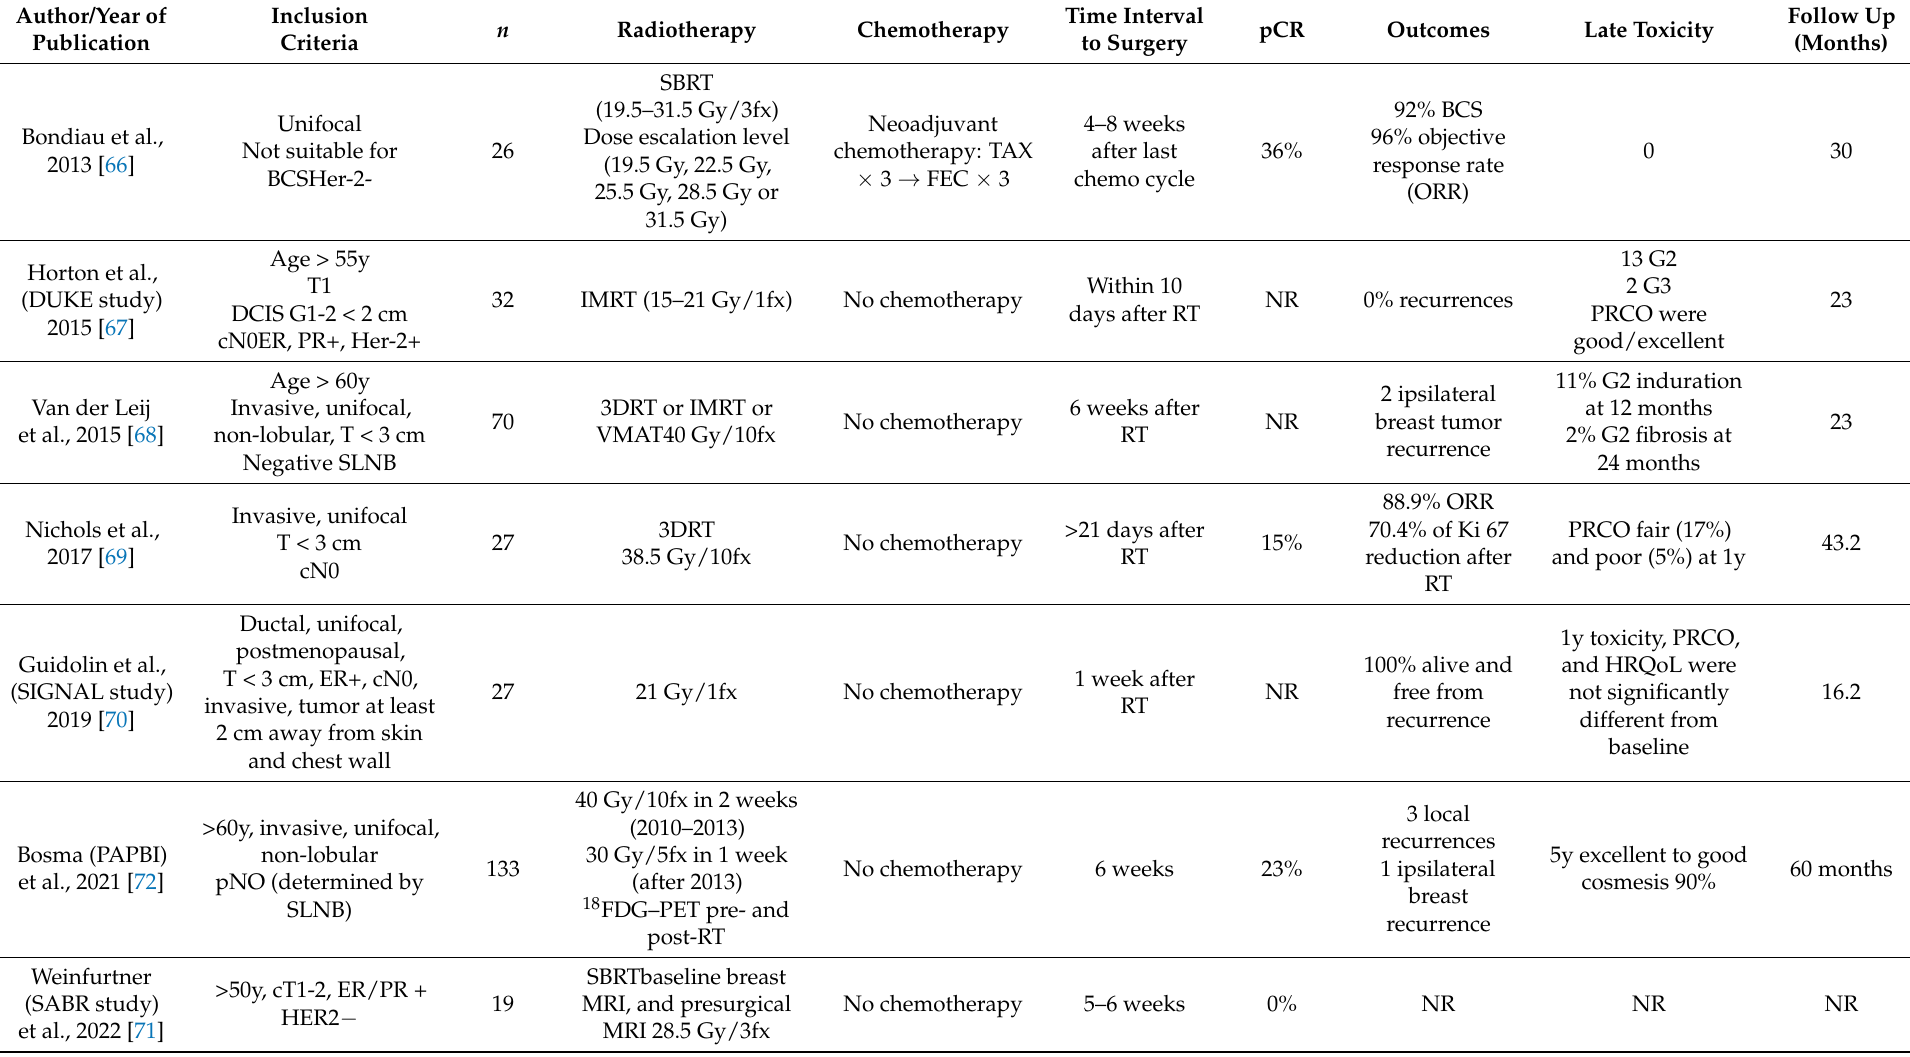
Table 3. Published preoperative accelerated partial breast irradiation